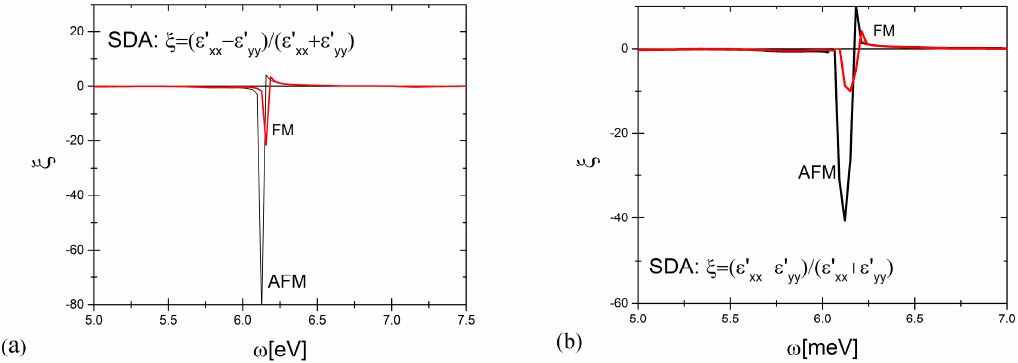
Figure 4. SDA spectra of CoO nanowires on Pt(322) in AFM (black curve)) and FM (red curve) spin configurations for high-energy ( a ) and for low-energy ranges ( b ).